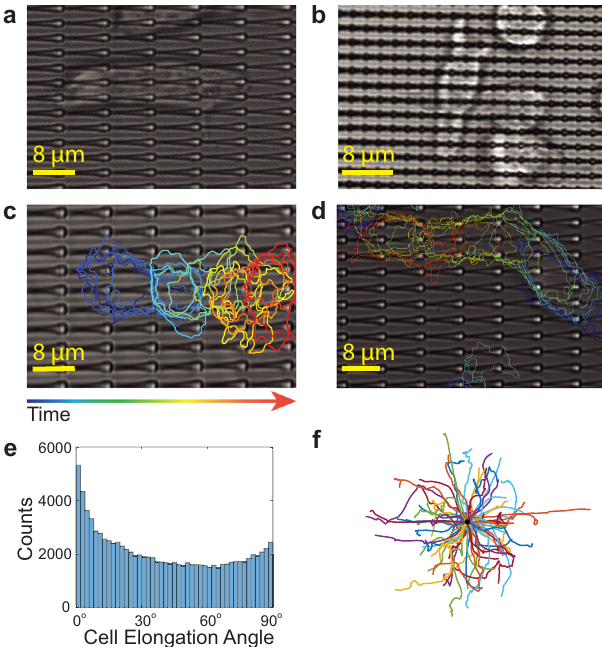
Fig. 4 Experimental data support the predictions of the model. D. discoideum cells on asymmetric sawteeth are observed to elongate both ( a ) parallel and ( b ) perpendicular to the sawtooth direction during cell migration. Motion of D. discoideum ( c ) down and ( d ) up the sawteeth. e The full distribution of elongation angles of D. discoideum on asymmetric sawteeth. The distribution is peaked around the parallel and perpendicular directions, as seen in the model. However, cells can exhibit other orientations as well. f The full distribution of directions of motion of D. discoideum on asymmetric sawteeth of heights 1 – 2.4 μ m. The model can also produce the full range of directions of motion (see Supplementary Fig.